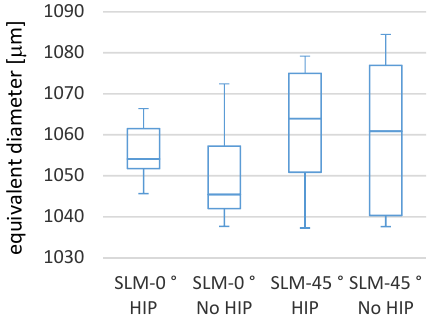
Figure 11. Box plots of the measured equivalent diameters of SLM and EBM manufactured parts. Box plots give the median value, the interquartile range (IQR: interval between the 25th and 75th percentile, blue rectangle) and the extremum values ( n = 10 measurements).